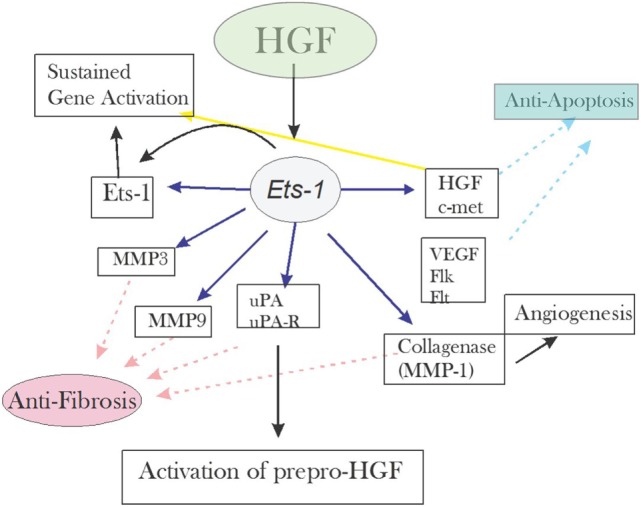
Redrawn from Ref. (19, 20).